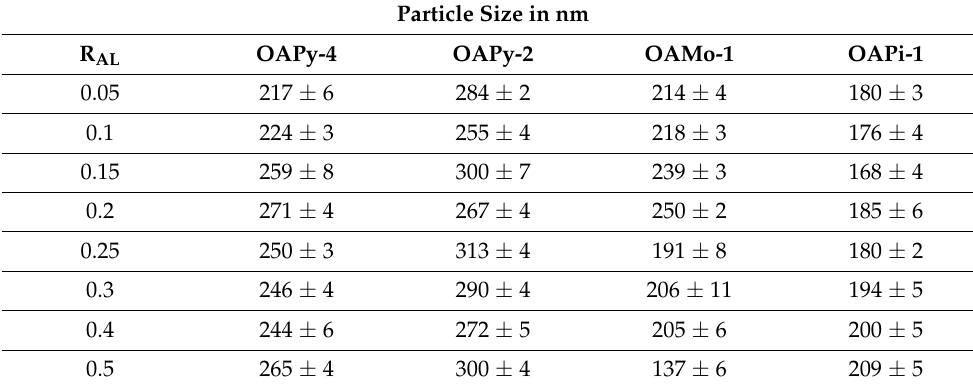
Table 1. Hydrodynamic diameter of nanoformulations prepared by adding aminolipids to MO dispersed with stabiliser Pluronic F-127. The amount of aminolipid added to the formulation is represented by R AL , which is defined as the wt./wt. ratio of aminolipid to total lipid. Measurements were averaged from triplicates, and the results are reported as the mean ± standard